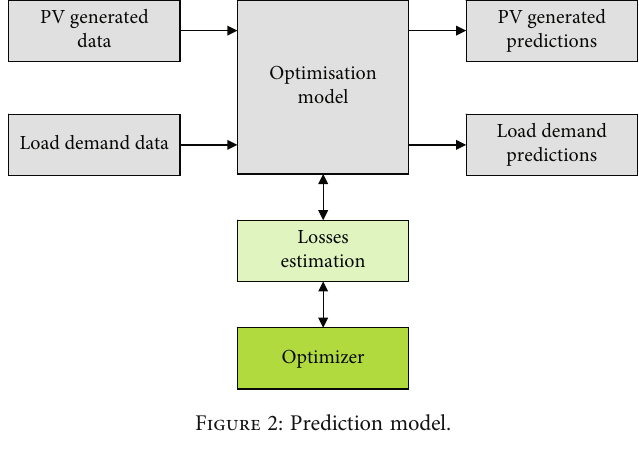
Figure 2: Prediction model.